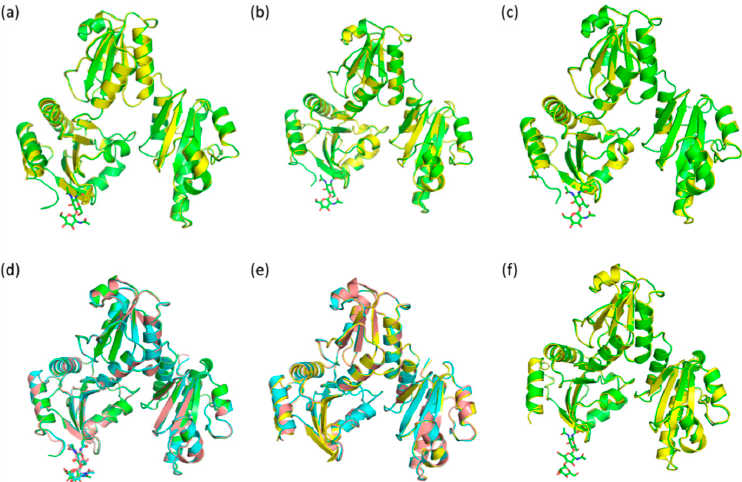
Figure 5. C α atoms’ superposition of the high-Ca 2+ native (green) and recombinant (yellow) bovine Casq1 ( a ) chain A, ( b ) chain B and ( c ) chain C; ( d ) C α superposition of the high-Ca 2+ native chains A (green), B (teal) and C (tan); ( e ) C α atoms’ superposition of the high-Ca 2+ native chains A (yellow), B (teal) and C (tan); ( f ) C α atoms’ superposition of the low-Ca 2+ native (green) and recombinant (yellow) bovine Casq1 structures. All superpositions were of residues Pro7 through Pro334, which correspond to Domains I through III, with the last secondary structural element of Domain III, α 12 (residues Ser335 through Gly349) and residues 350 through 354 excluded.